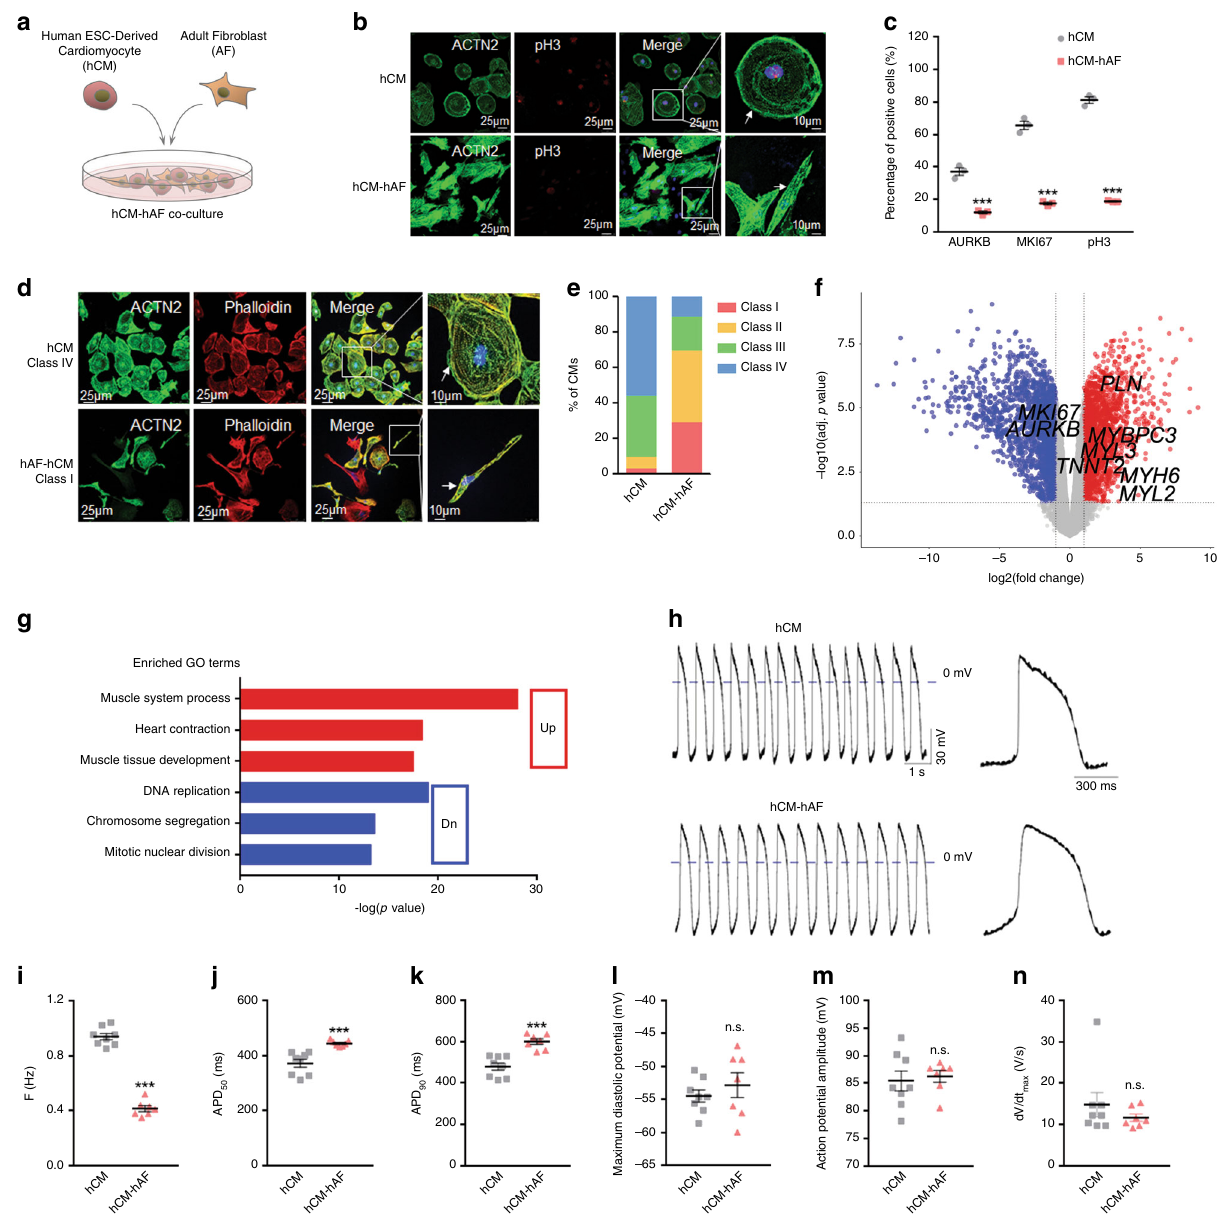
Fig. 9 Conserved role of FBs in human cell model. a Schematic of co-culture of human cells in vitro. Cardiomyocytes induced from human embryonic stem cells (hESC-CMs) were co-cultured on a monolayer of cardiac fi broblasts isolated from adult human heart (hAFs). b Immuno fl uorescent staining against ACTN2 and pH3 in hESC-CMs 7 days after co-culture with or without hAFs, respectively. White arrows indicate co-localized cells. Scale bars = 10 or 25 μ m. c Quanti fi cation of ACTN2 + AURKB + , ACTN2 + MKI67 + , and ACTN2 + pH3 + cells. d Immunostaining against ACTN2 and Phalloidin in the co-culture sys- tem. Representative images to show typical class I and class IV hESC-CM morphology when co-cultured with or without hAF, respectively. e Percentage of CMs in different morphology grades. f Volcano plot to show DEGs in hESC-CMs only versus those co-cultured with hAF. Red indicates upregulated genes, and blue represents downregulated genes upon AF co-culture. g Gene ontology analyses of upregulated or downregulated genes ( f ). Selected top categories are shown. h Representative action potential tracings of hESC-CMs alone or in co-culture with hAFs, respectively. i – n Quanti fi cation of bea- ting frequency ( i ), action potential duration to 50% repolarization (APD50, j ), to 90% repolarization (APD90, k ), maximum diastolic potential (MDP, l ), amplitude of action potential (APA, m ), and maximum rate of rise (d V /d t max ) of action potential ( n ) in ( h ). n = 8 cells in hCM, = 7 cells in hCM-hAF. All data in this fi gure are plotted as mean ± SEM from three biologically independent experiments, *** p < 0.001, n.s. not signi fi cant, two-sided Student ’ s t -test. Source data are provided as a Source Data fi